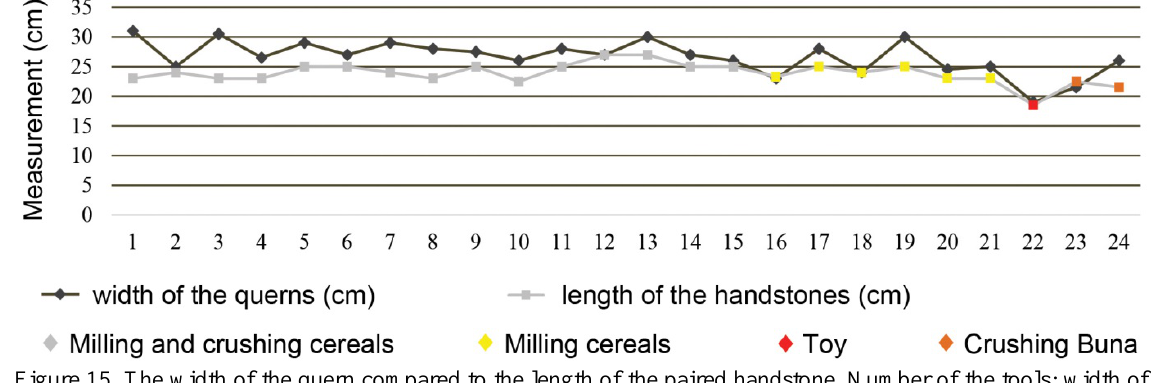
Figure 15. The width of the quern compared to the length of the paired handstone. Number of the tools: width of the quern / length of the handstone. Tools used for milling and crushing cereals. 1:31/23 ; 2:24/25 ; 3: 30,5/23 ; 4:26,5\23 : 5:29/25 : 6:27/25 : 7:29/24 ; 8:28/23 ; 9:27,5/25 : 10: 26/22,5 ; 11:28/25 ; 12:27/27 ; 13:30/27 ; 14:27/25 ; 15:26/25. Tools used for milling cereals. 16:23/23,3 ; 17:28/25 ; 18:24/24 ; 19:30/25 ; 20:24,5/23